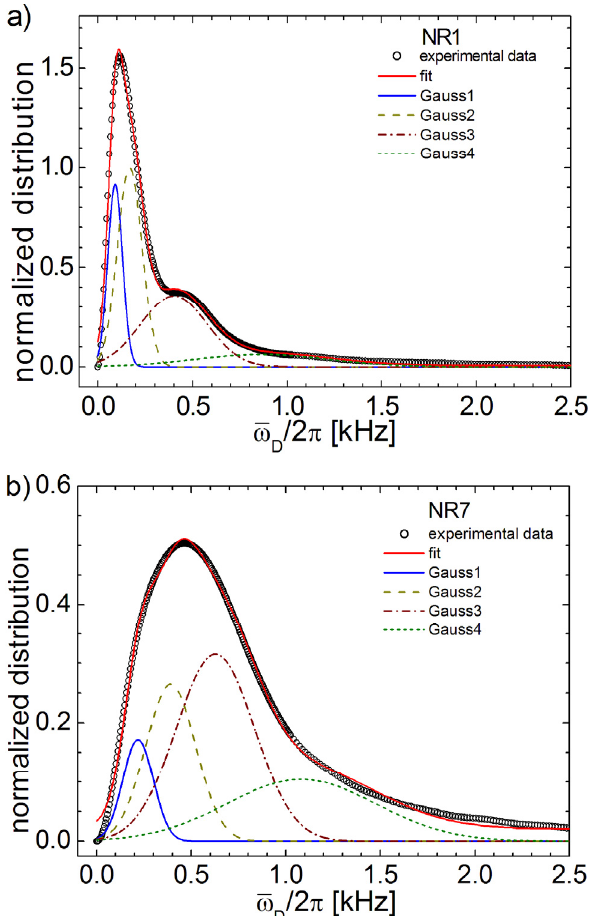
Figure 6. The deconvolution fit (continuous line) of DQ Fourier spectra (open circles) of six-years aged NR1 ( a ) and NR7 ( b ) cross-linked natural rubber. The best fits were obtained with a sum of four Gaussian functions described by Equation (16) and are shown with continuous, dashed, dash-dot and small-dash lines.